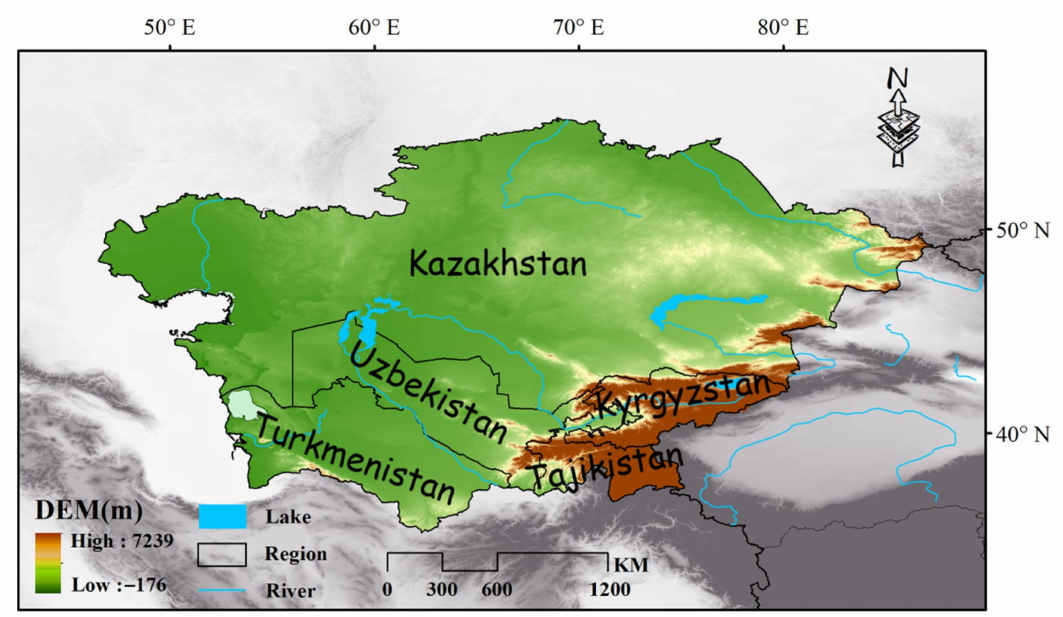
Figure 1. Study area. No. GS (2016)